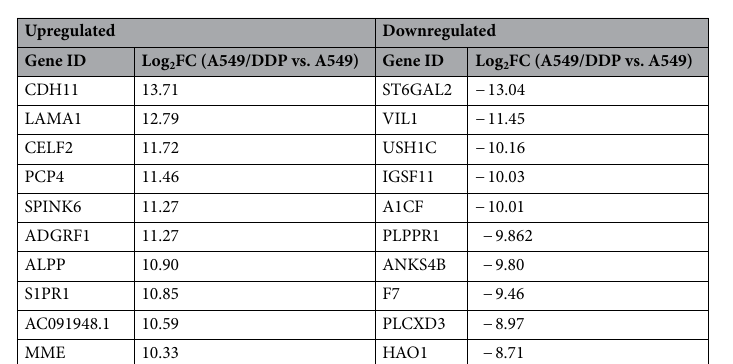
Table 2. Top 10 down- and up-regulated mRNAs in A549/DDP vs. A549 cells, as were detected by RNA-seq.